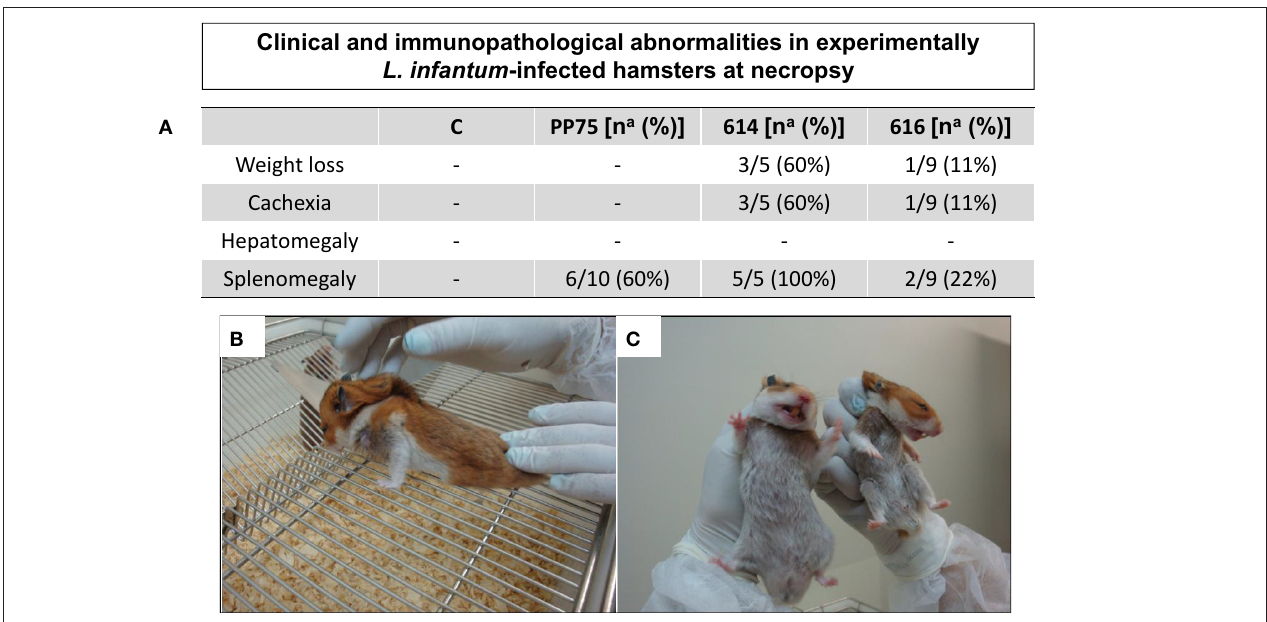
FIGURE 3 | Clinical/immunopathological abnormalities observed in experimentally L. infantum -infected hamsters at necropsy. (A) Frequency [number of positive hamsters in relation to total analyzed animals – n a ; and respective percentage (%)] of immunopathological changes according the analyzed groups [C, control; experimentally L. infantum -infected wild (614 and 616) and reference (PP75) strains]. Animals from 614 ( n = 5) group died before the end of the experiment, as demonstrated in the survival rate displayed in Figure 2 ; (B) Hamster infected with 614 strain displaying weight loss and cachexia; (C) normal hamster (at left) and an animal with cachexia and weight loss (at